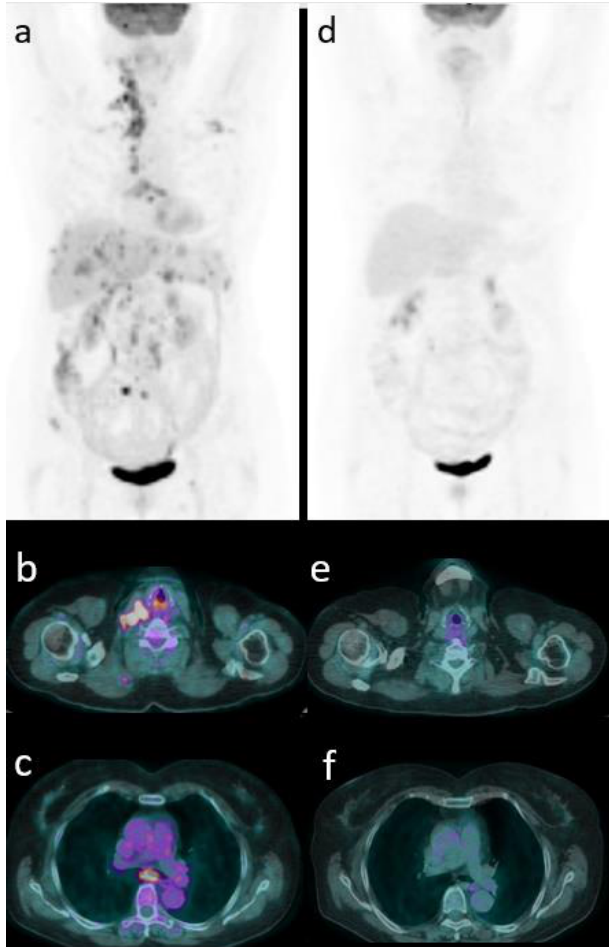
Figure 2. Baseline 18 F-FDG PET/CT ( a ) in a MCD patient with multiple lymph nodes above and below diaphragm with increased FDG uptake, such as in the right neck ( b ) and in sub-carena ( c ). PET/CT after 4 cycles of Rituximab showing a complete metabolic response ( d ) with the disappearance of the previous pathological lymph nodes ( e , f ) (Deauville score 1).